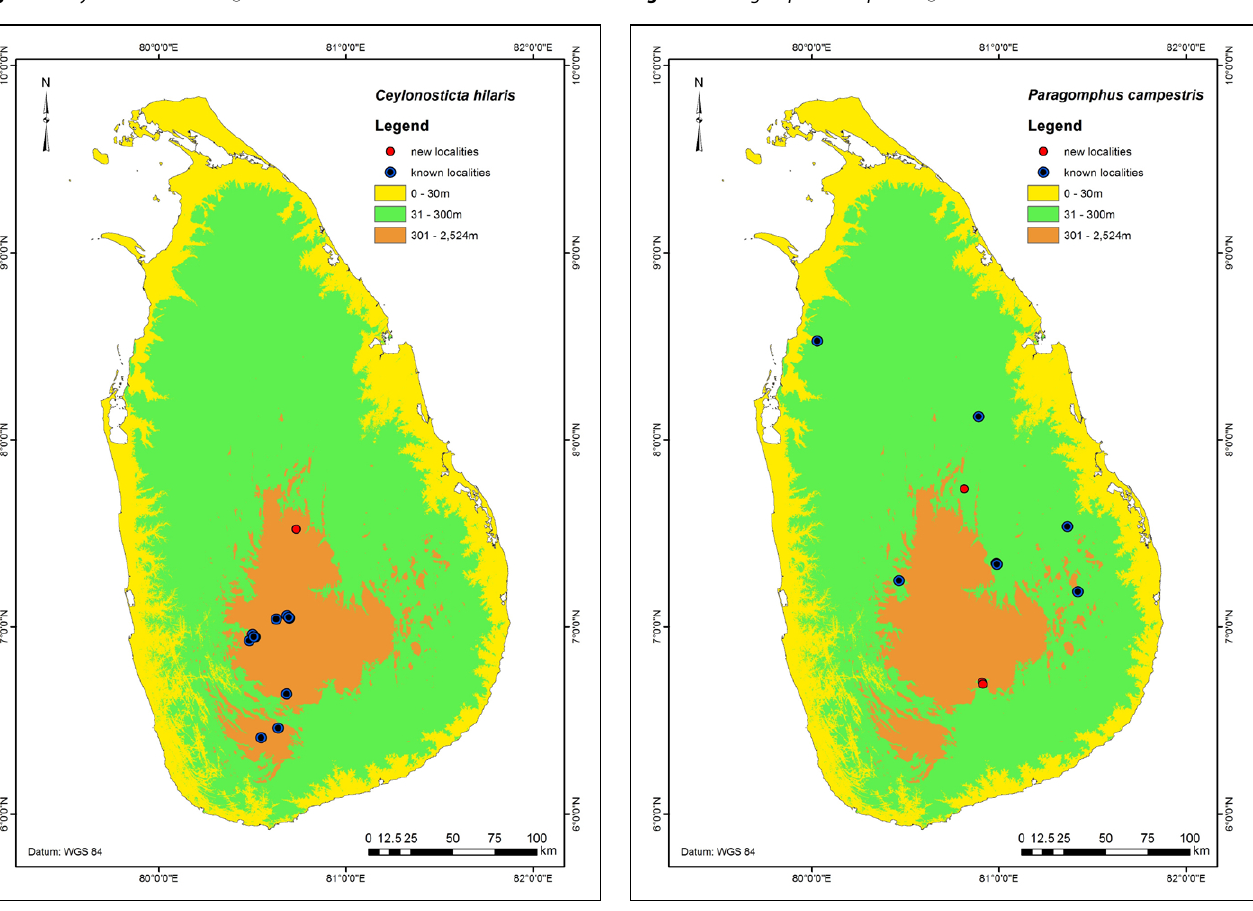
Figure 7. Ceylonosticta hilaris ♂ . Figure 9. Paragomphus campestris ♂ .